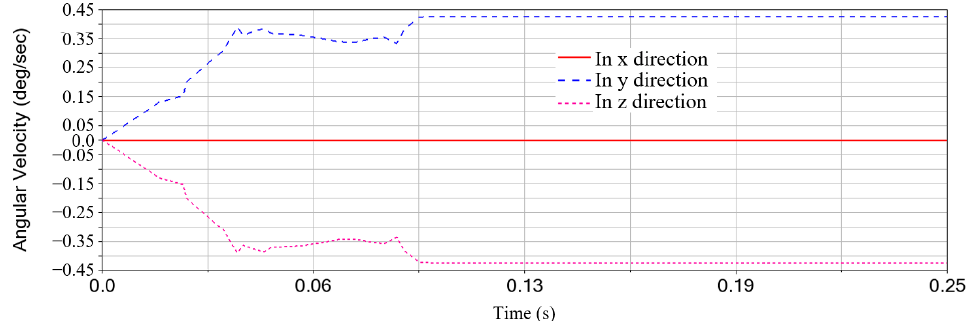
Figure 11. Separation angular speed of the 1U CubeSat.